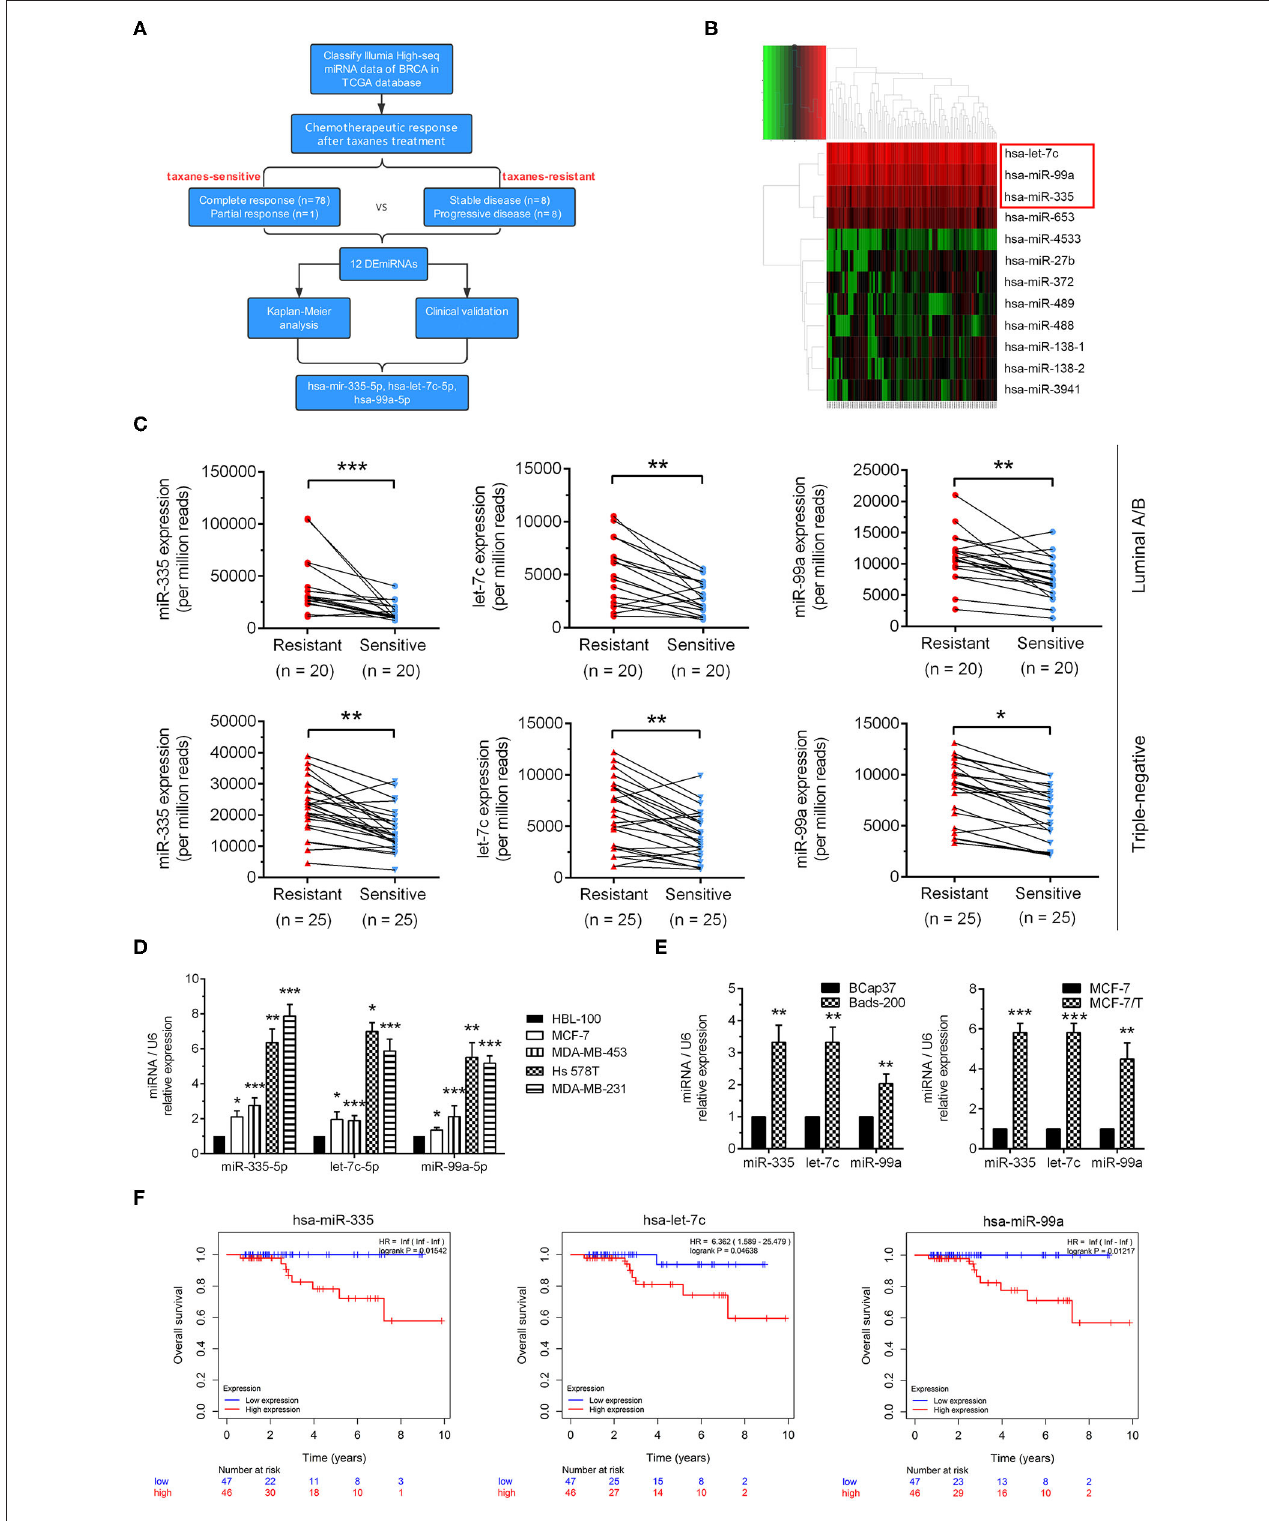
FIGURE 1 | Identification of dysregulated miRNAs relevant to taxanes-resistance in breast cancer. (A) The workflow of identification of miRNAs relevant to taxanes-resistance in breast cancer. (B) The heatmap showed dysregulated miRNAs in tumor tissues from comparation of taxanes-resistant and taxanes-sensitive